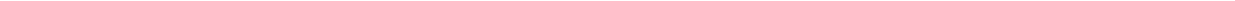
Fig. 3 Endosomal ROS production to ssRNA and DNA viruses are via TLR7 and TLR9-dependent mechanisms, respectively. a Endosomal ROS production in WT and TLR7 − / − bone marrow-derived macrophages as assessed by OxyBURST (100 μ M) fl uorescence microscopy in the absence or presence of in fl uenza A virus (HKx31 virus), rhinovirus (rhino), respiratory synctitial virus (RSV), human parain fl uenza virus (PIV), human metapneumovirus (HMPV), sendai virus, dengue virus, human immunode fi ciency virus (HIV), mumps virus (MuV), Newcastle disease virus (NDV), rotavirus (UK and bovine strains), herpes simplex virus 2 (HSV-2), and vaccinia virus and labeled with 4 ′ ,6 ′ -diamidino-2-phenylindole (DAPI). Also shown is the quanti fi cation of the results ( n = 5). b Endosomal ROS production in WT and TLR9 − / − mouse primary alveolar macrophages as assessed by OxyBURST fl uorescence microscopy in the absence or presence of HKx31 virus, rhinovirus, sendai virus, dengue virus, and herpes simplex virus 2 (HSV-2) and labeled with DAPI ( n = 5). a and b Images are representative of > 150 cells analyzed over each experiment. Original magni fi cation ×100. All data are represented as mean ± S.E.M. One-way ANOVA followed by Dunnett ’ s post hoc test for multiple comparisons. # P < 0.05 compared to WT control. * P < 0.05 comparisons indicated